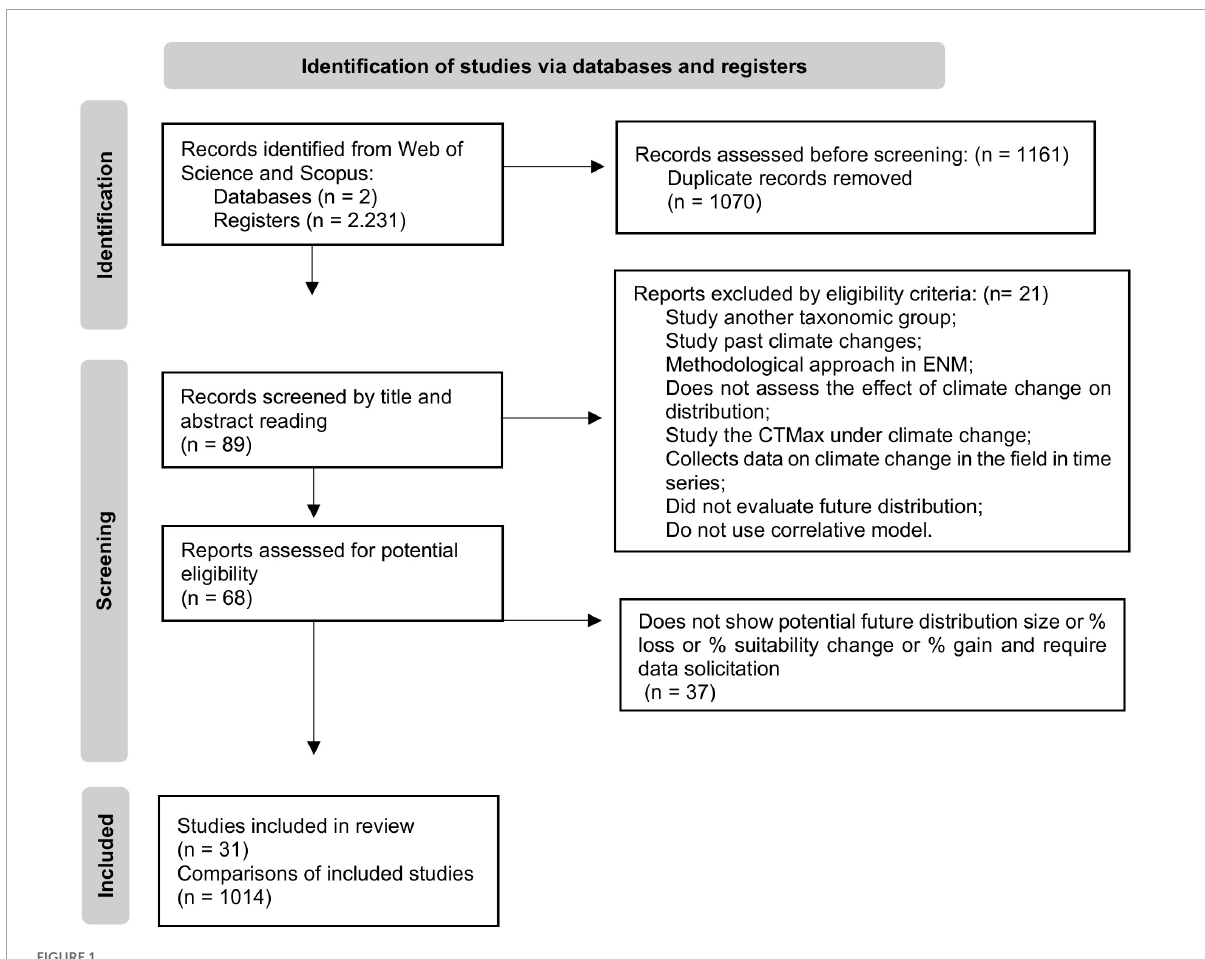
FIGURE1 PRISMA diagram representing the selection process of the studies included in our